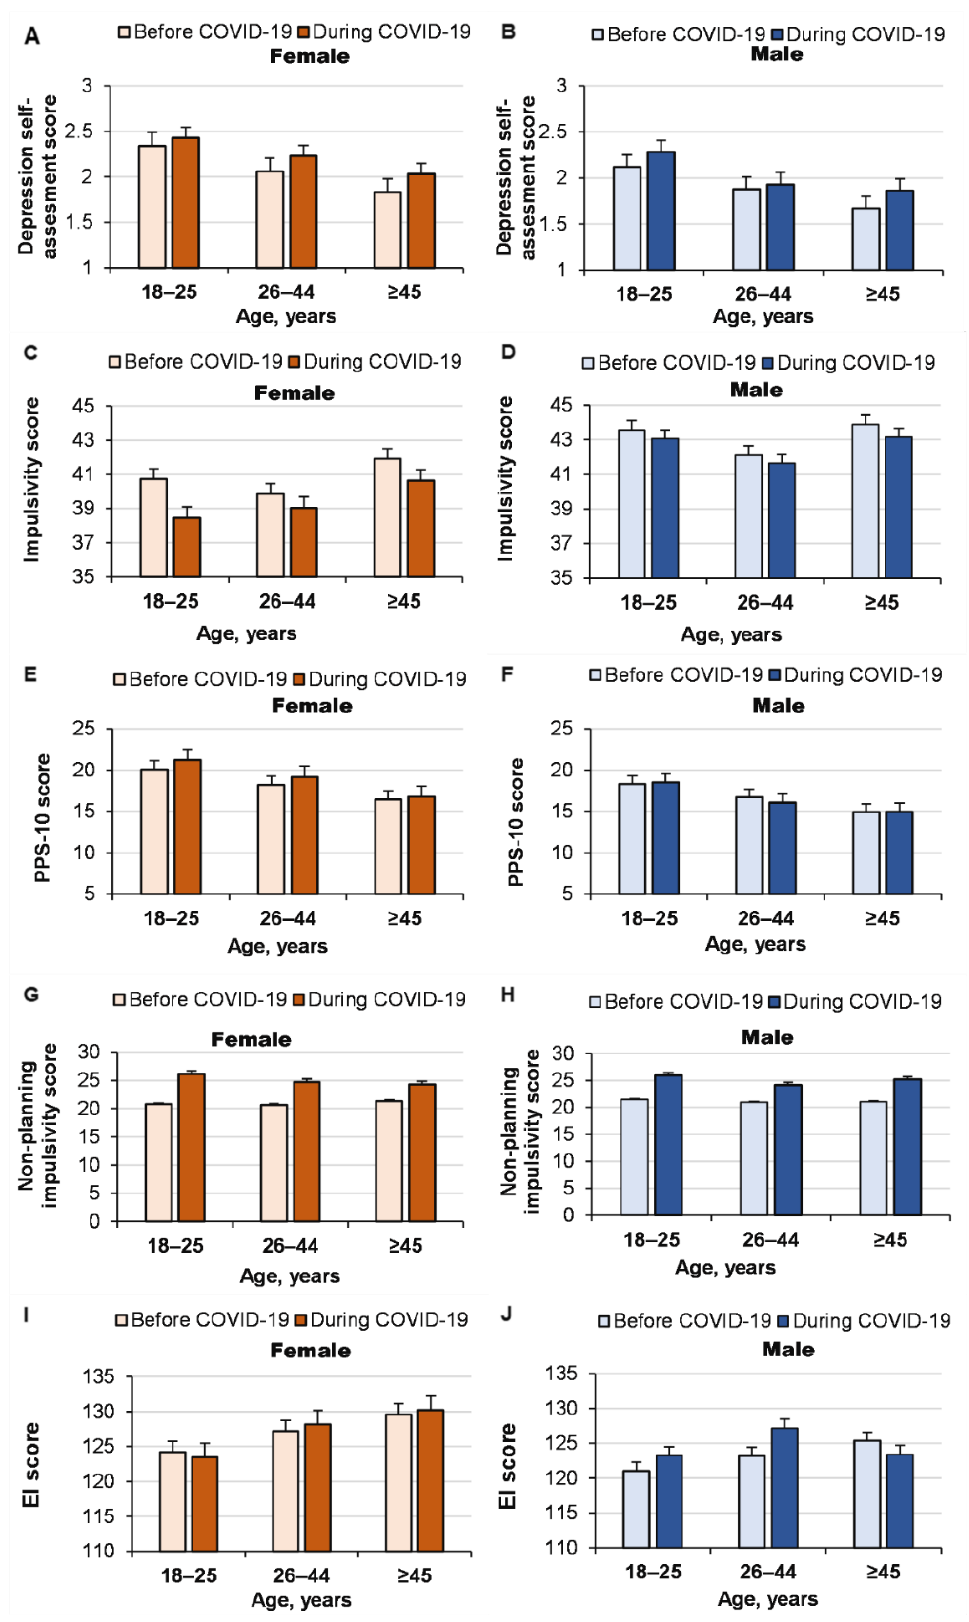
Figure 2. Effect of the COVID-19 pandemic on depression (A,B), impulsivity (C,D), stress (evaluated using the PSS-10) (E,F), non-planning impulsivity (G,H) and EI (I,J) in women and men of different ages .